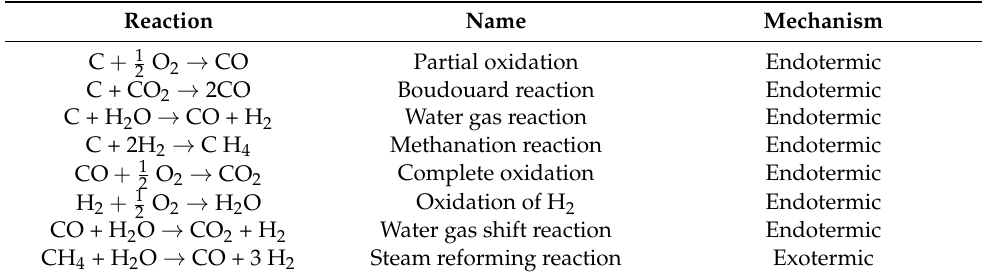
Table 1. Thermochemical gasification reactions (adapted from [25,26]).